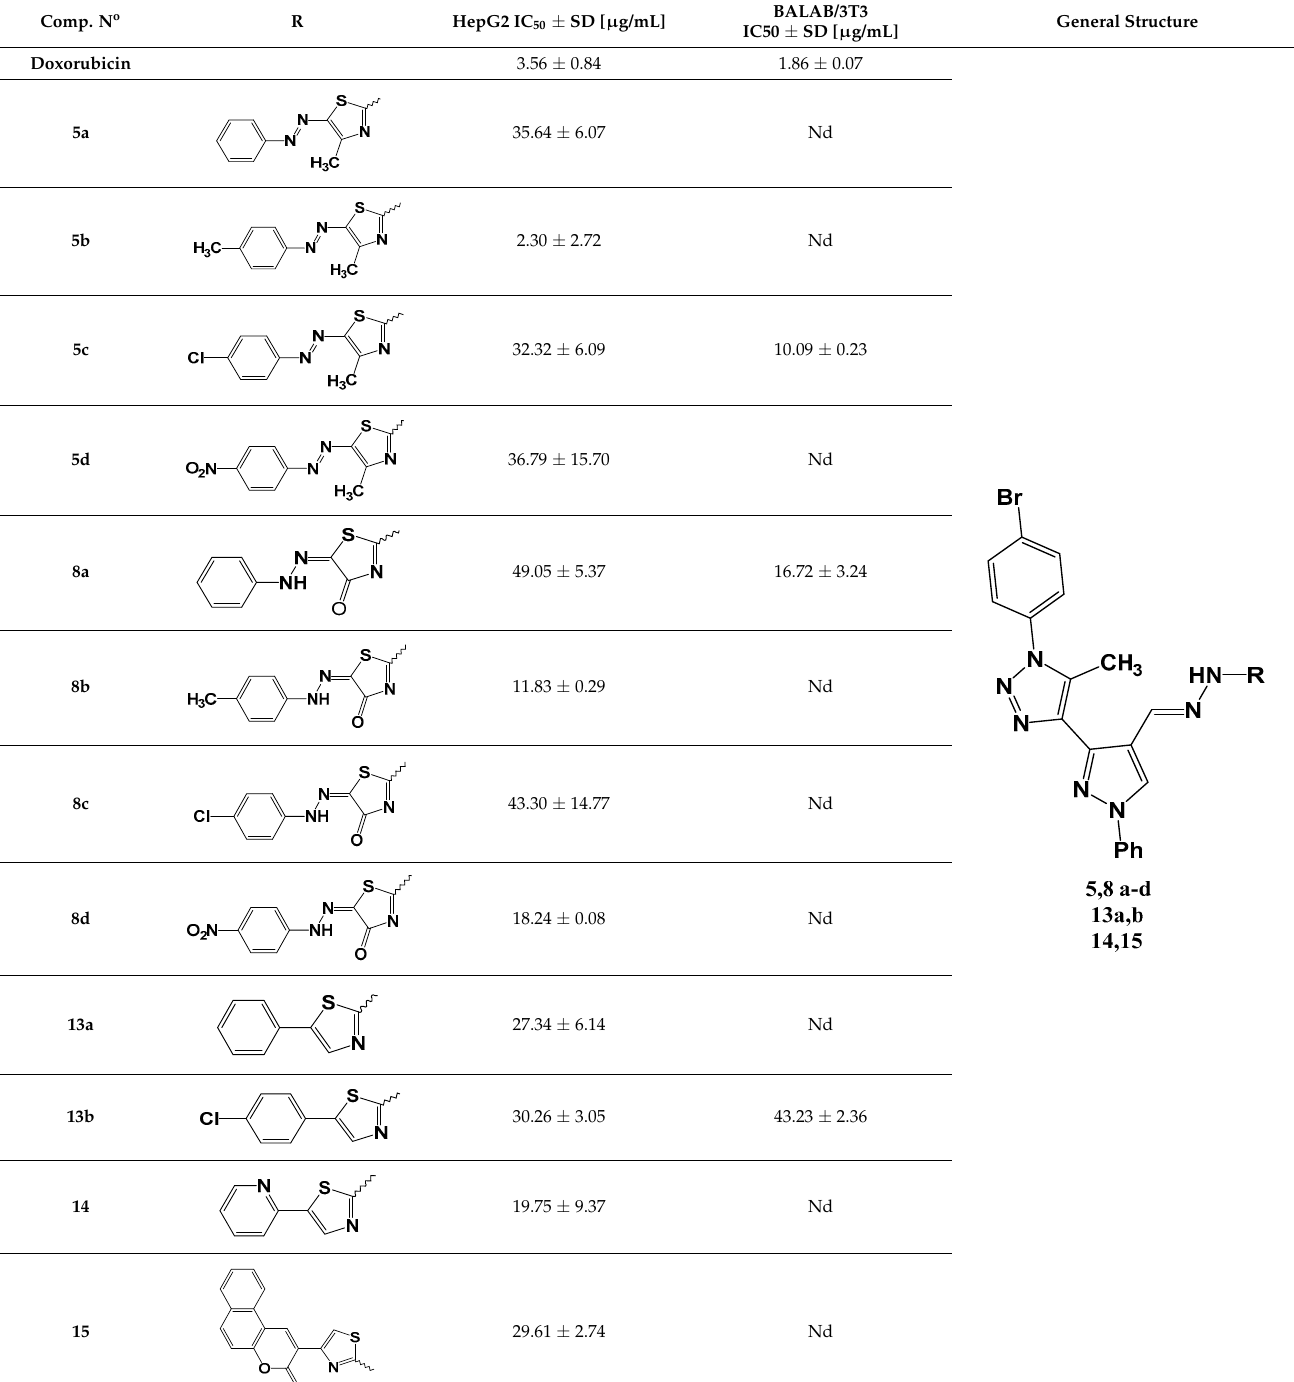
Table 3. Antiproliferative activity of the new derivatives towards liver (HepG2) and normal (BALAB/3T3) cell lines. Comp. N o